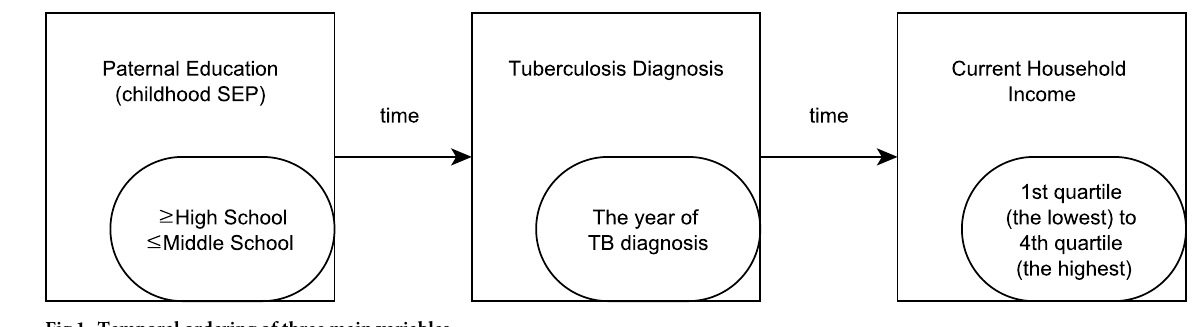
Fig 1. Temporal ordering of three main